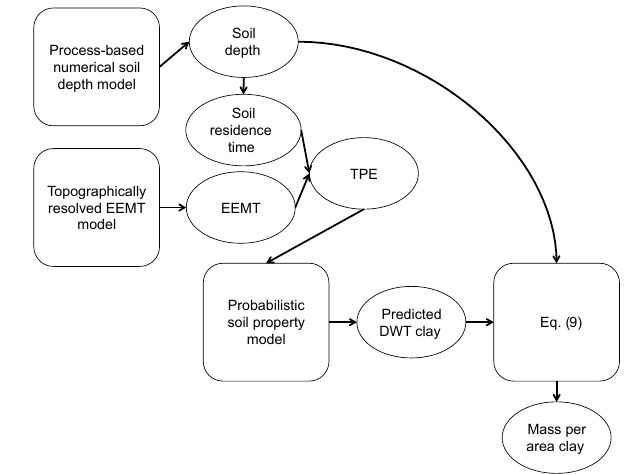
Figure 3. Coupled geomorphic–probabilistic model apparatus. The process-based numerical soil depth model is used to predict soil depth, which is used to predict soil residence time. The topographi- cally resolved EEMT model is used to calculate TPE using the soil residence time and EEMT values. The probabilistic model is used to calculate DWT clay contents using the TPE values, and mass per area clay is calculated using predicted DWT clay and predicted soil depth